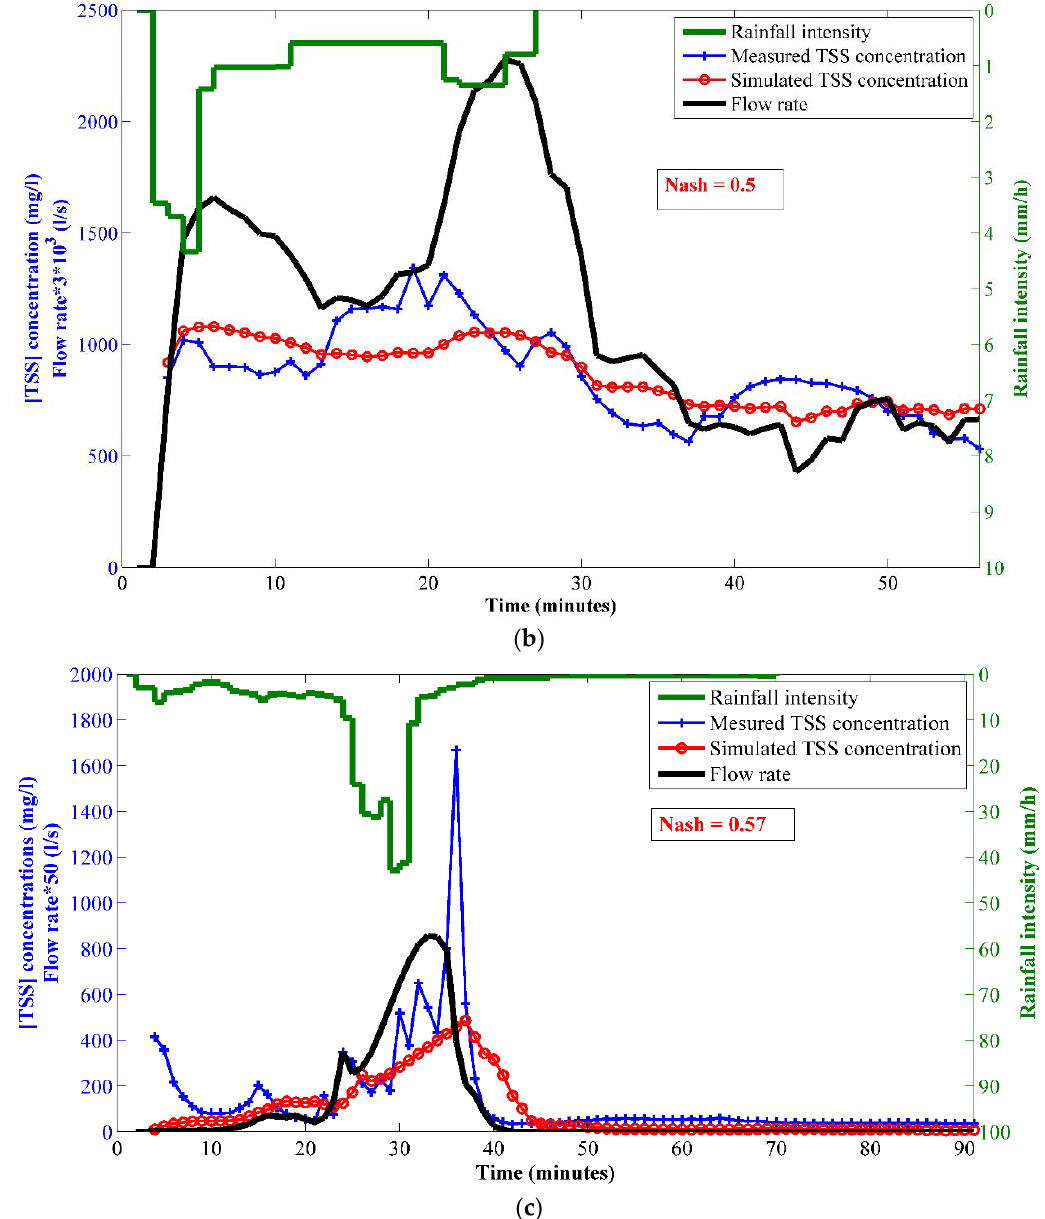
Figure 6. Calibration results for the rainfall events of: ( a ) 14 February 15 (First flush event); ( b ) 27 December 14 (Uniformly distributed event); and ( c ) 13 January 15 (Last flush event).